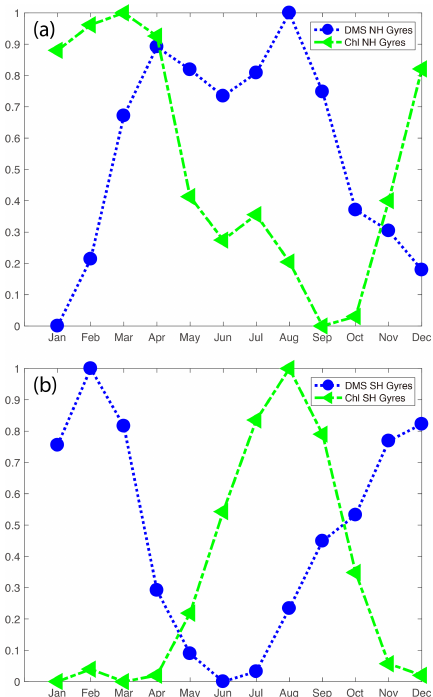
Figure 6. Distributions of monthly mean DMS and Chl a concen- trations for Northern Hemisphere and Southern Hemisphere gyres (NH and SH respectively). The gyres are defined as regions between 30 ◦ and the Equator where annually mean DIP concentration is be- low 0.2µM. Monthly mean concentrations are normalized to the range of 0 to